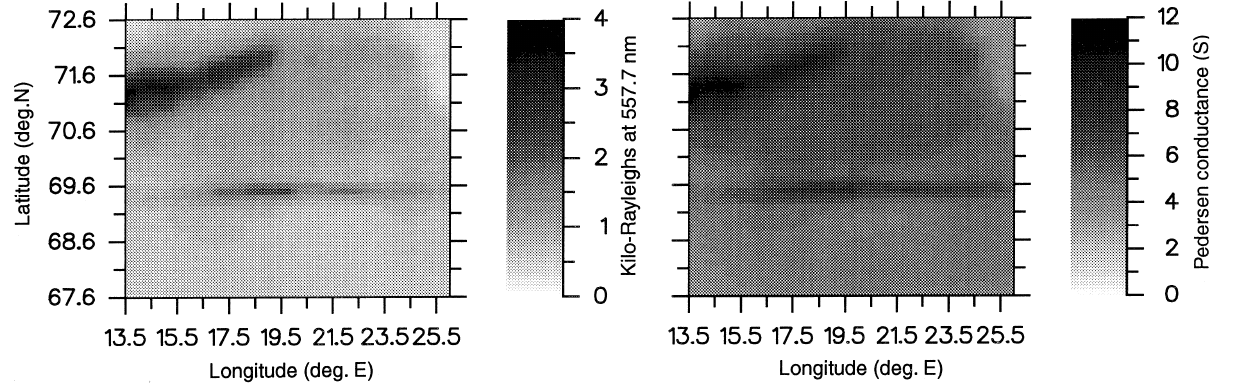
Fig. 3. An example of an auroral image taken by DASI calibrated in Rayleighs and the computed distribution of Pedersen conductance resulting from auroral precipitation. The left panel shows a 10 s